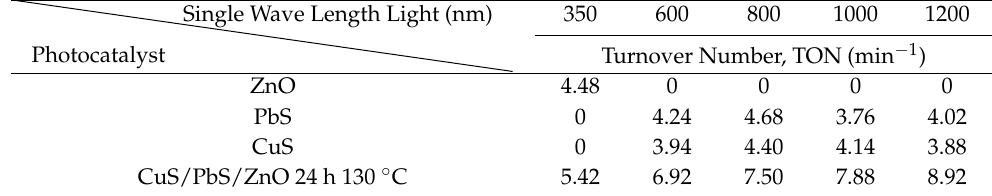
Table 3. Evaluation of single and heterojunction photocatalyst activities at monochromatic light.